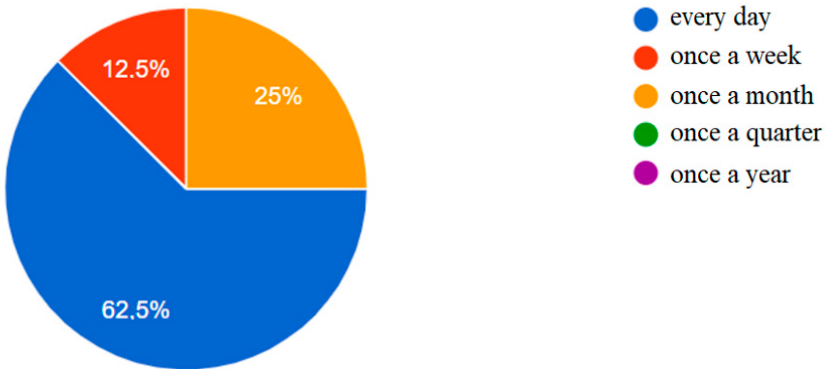
Figure 3. Frequency of supply chain disruptions.